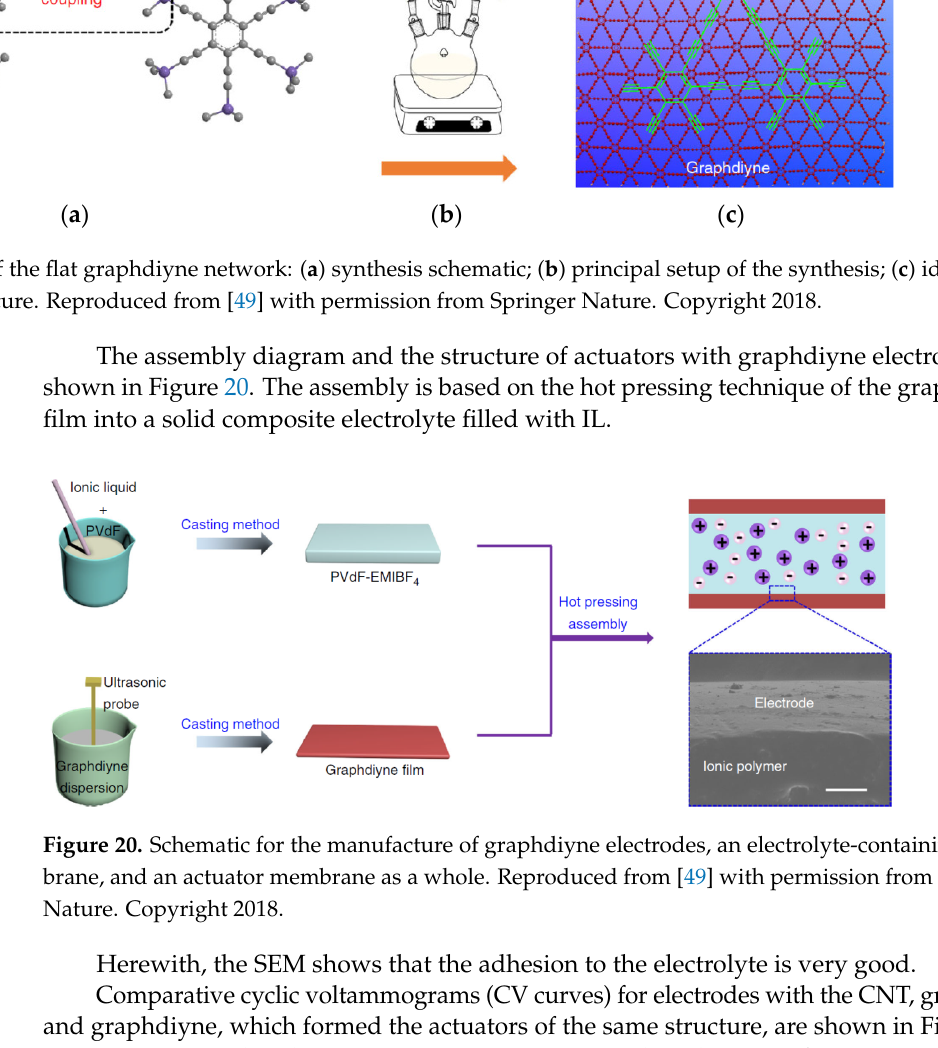
Figure 20. Schematic for the manufacture of graphdiyne electrodes, an electrolyte-containing membrane, and an actuator membrane as a whole. Reproduced from [49] with permission from Springer Nature. Copyright 2018.